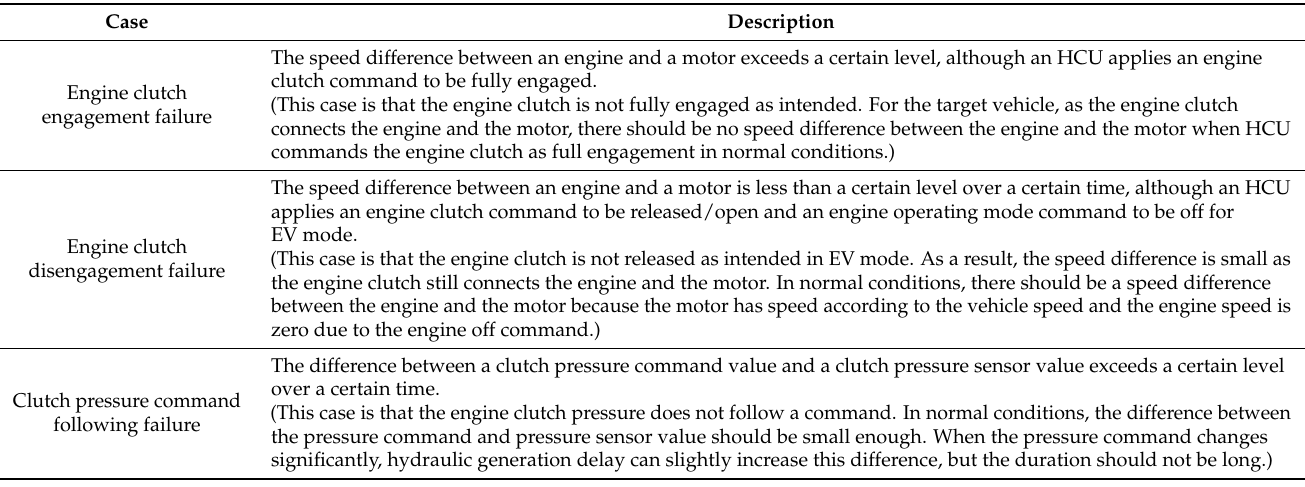
Table 1. Representative anomalous behaviors in engine clutch